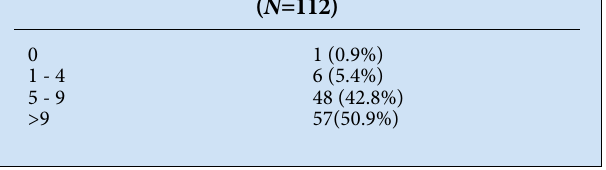
Table IV. Glomeruli found in the histological specimen